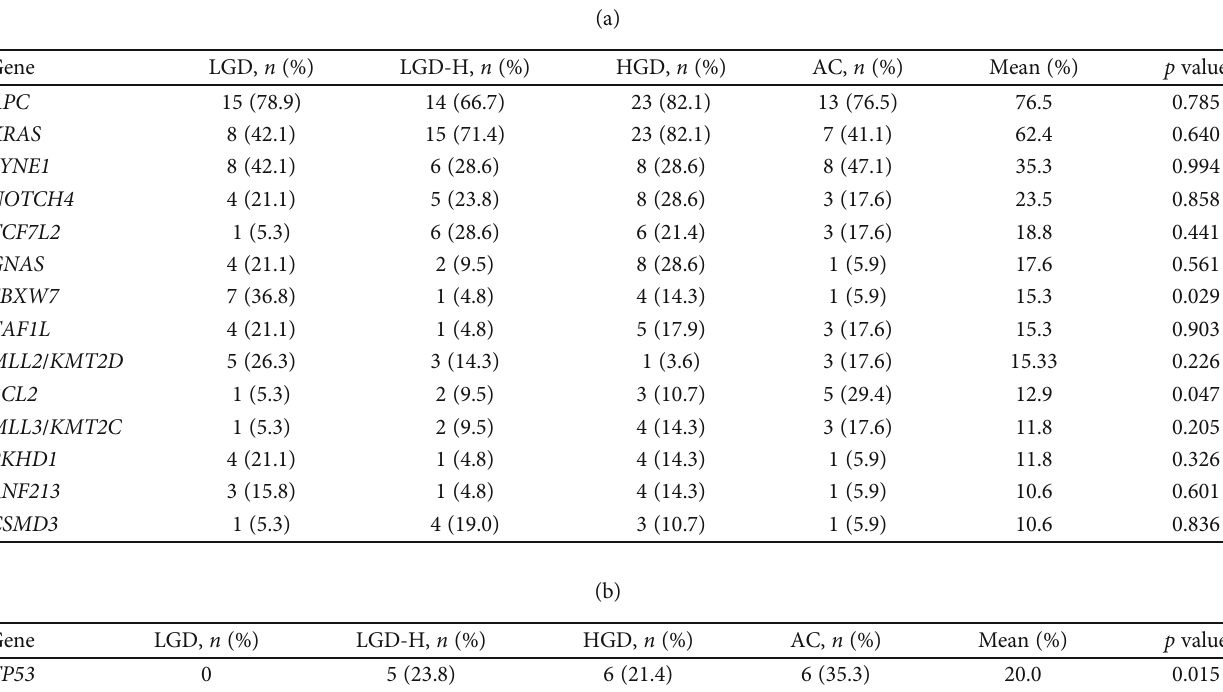
Table 2: Number of nonsynonymous mutations with percentages in di ff erent groups. p values are given for the results of the Cochran- Armitage trend test.